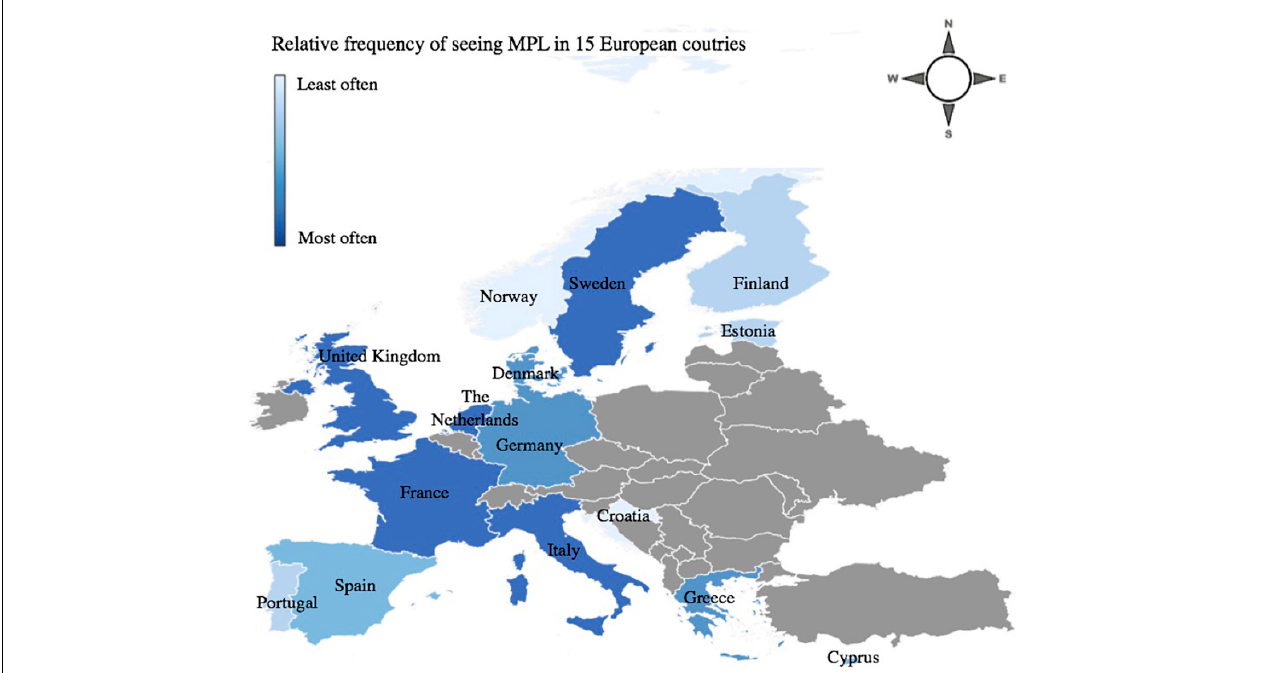
FIGURE 2 | Geographical distribution of mean scores of seeing marine plastic litter across visited European countries. The mean scores refer to the question “ How often did you see plastic litter on the beach or in the water? ”, where the answers are 1 = never; 2 = sometimes; 3 = often; 4 =